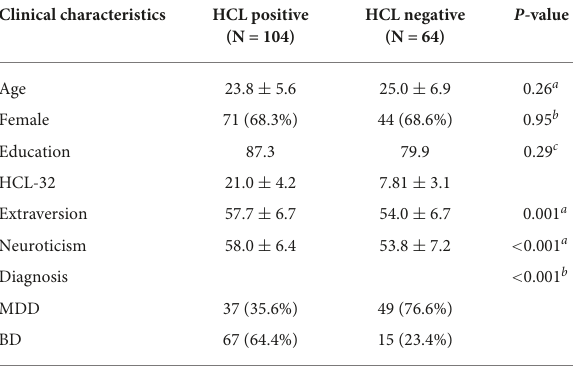
TABLE 2 Number of subjects with different personality traits.